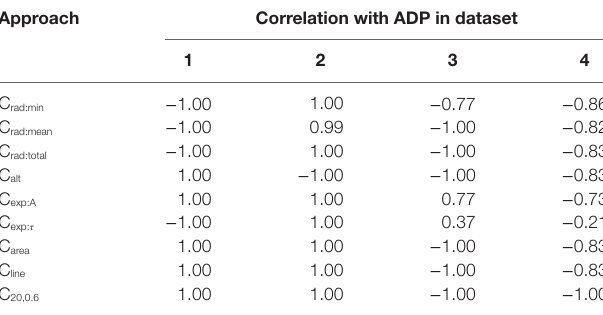
tABLe 3 | Spearman’s rank correlation between the convexity measures obtained via the different quantification approaches and the extent of ADP. Approach Correlation with AdP in